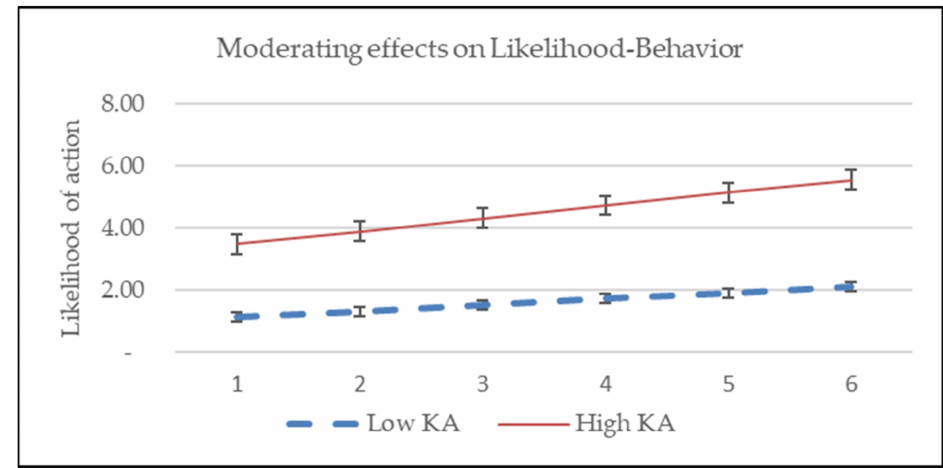
Figure 3. KA has no moderating effects on likelihood of action and intention.